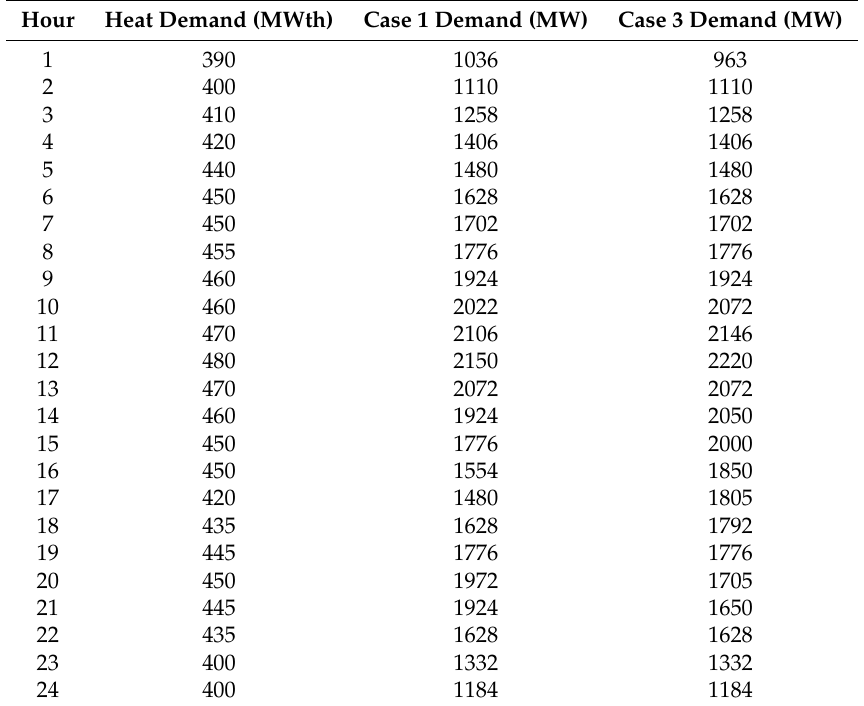
Table 4. Heat demand and power